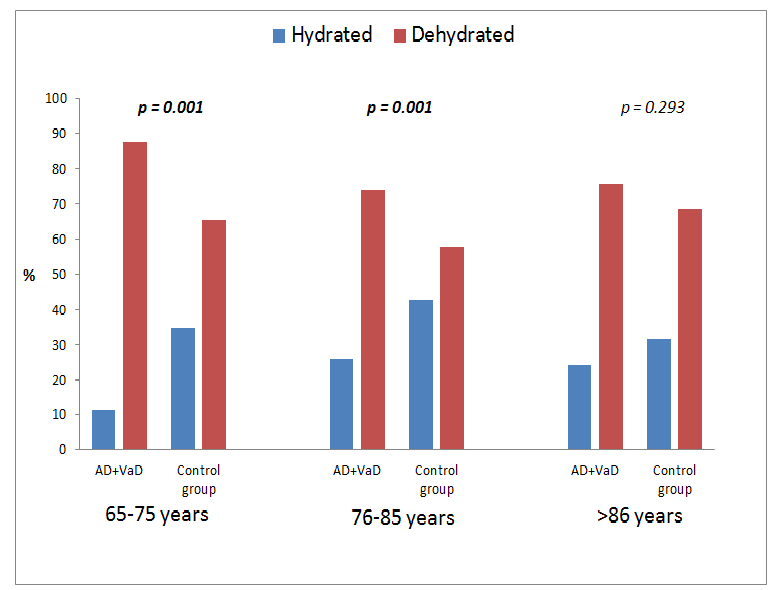
Figure 3. Distribution of dementia (AD and VaD) patients and control group according to dehydration risk and age.